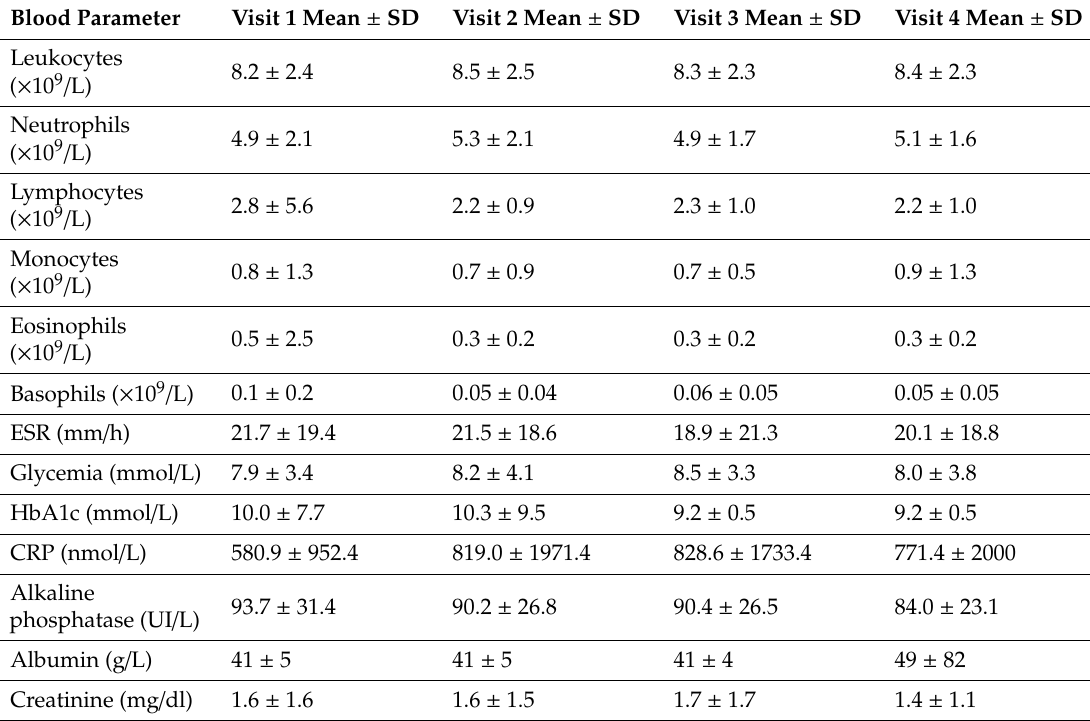
Table 2. Blood test—values of blood parameters.